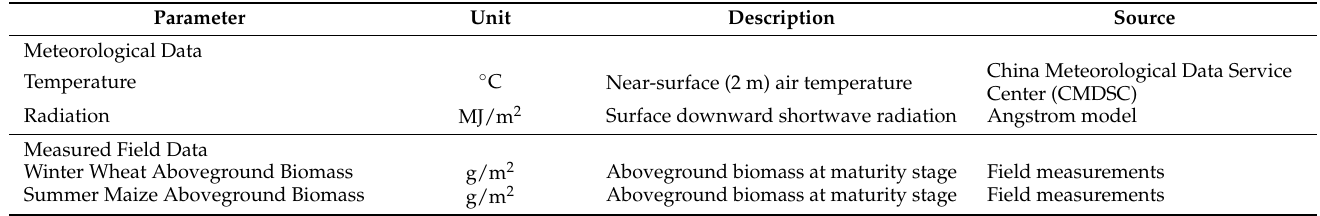
Figure 3. Field survey of winter wheat and maize. ( a , b ) The sampling of winter wheat. ( c , d ) The sampling of maize. Table 2. Parameter values used for aboveground biomass estimation.